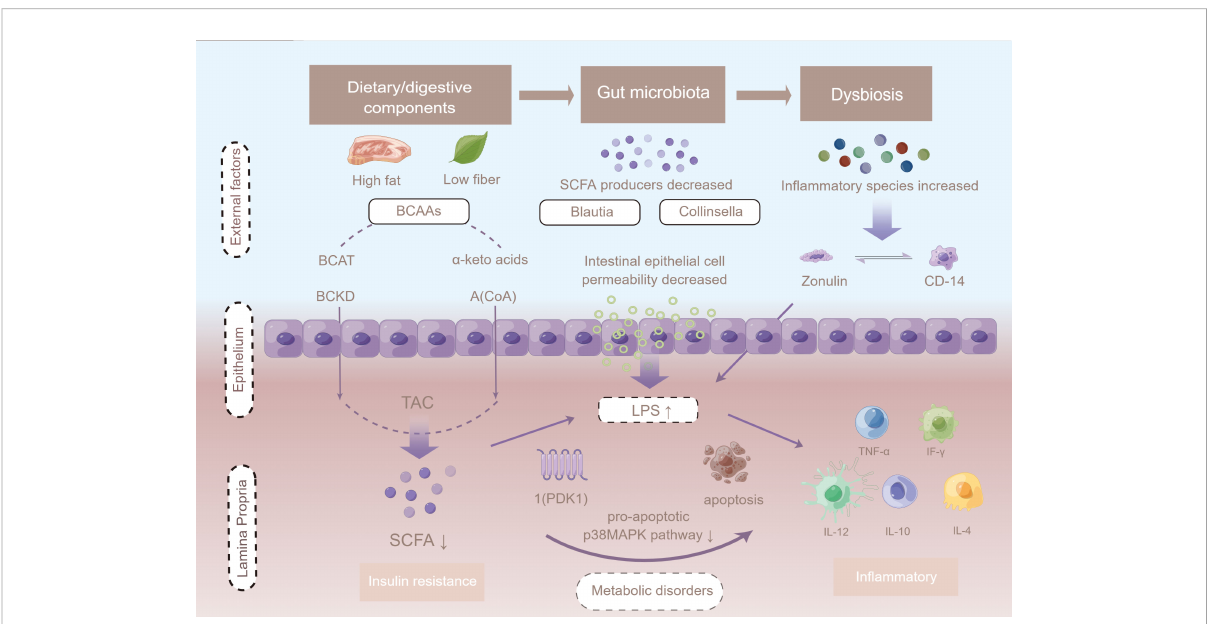
FIGURE 4 The potential mechanism linking gut dysbiosis and GDM. Intestinal permeability is regulated by dietary factors and the zonulin pathway. Cells in the basal layer of the intestinal epithelium secrete zonulin and bind to initiate complex intracellular signaling pathways, allowing phosphorylation of tight junctions. When LPS is ready to enter the advocate circulation, it increases absorption, and forms a complex with LBP that further binds CD14 released from monocytes, leading to the production of pro-in fl ammatory cytokines mediated by the MD2/TLR4 receptor complex, such as TNF- a , interleukin 1 (IL-1), and interleukin 6 (IL-6). LPS in fi ltrates peripheral adipose tissue and binds to TLRs, thus activating the adaptor proteins MyD-88, IRAK, TAK1, and TRAF6, and triggering macrophage in fi ltration and up-regulation of in fl ammatory pathways. Up-regulation